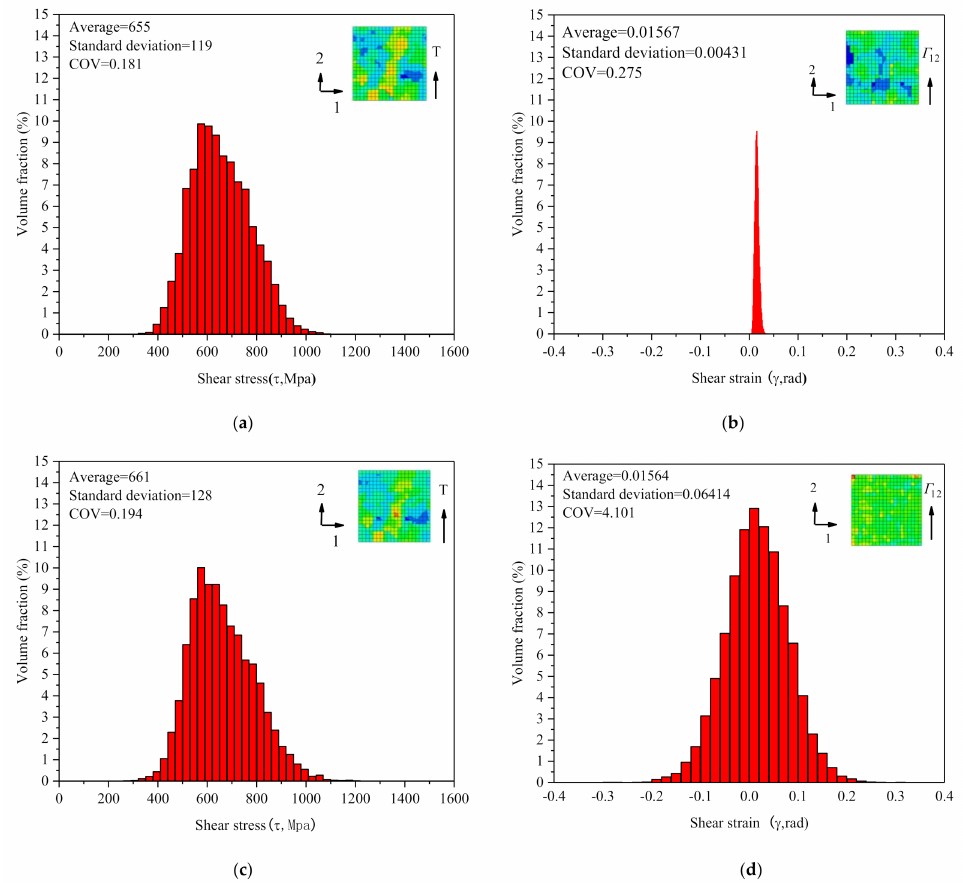
Figure 11. ( a , b ) Statistical distribution of shear stress and shear strain for the RVE at the shear stress peak of the 7th cycle, respectively; ( c , d ) statistical distribution of shear stress and shear strain for the RVE at the shear stress peak of the 560th cycle, respectively. Shear strain amplitude is γ a / Accordingly, based on the above analysis and reference to the research in [39], the standard deviation of shear strain is used as the basis of the FIP to describe the shear fatigue damage in the following